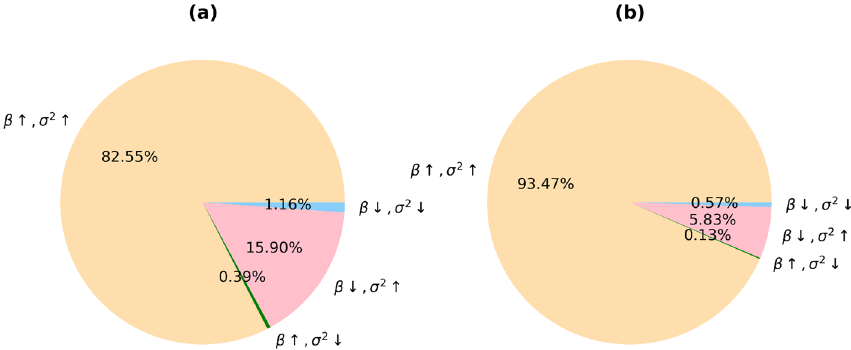
Figure 5. The percentage of aDaVMPs with different quality types of methylation and variability changes in GSE87571 dataset for males ( a ) and females ( b ): case of methylation and variability increasing (beige); case of methylation and variability decreasing (lightblue); case of methylation decreasing and variability increasing (pink); case of methylation increasing and variability decreasing